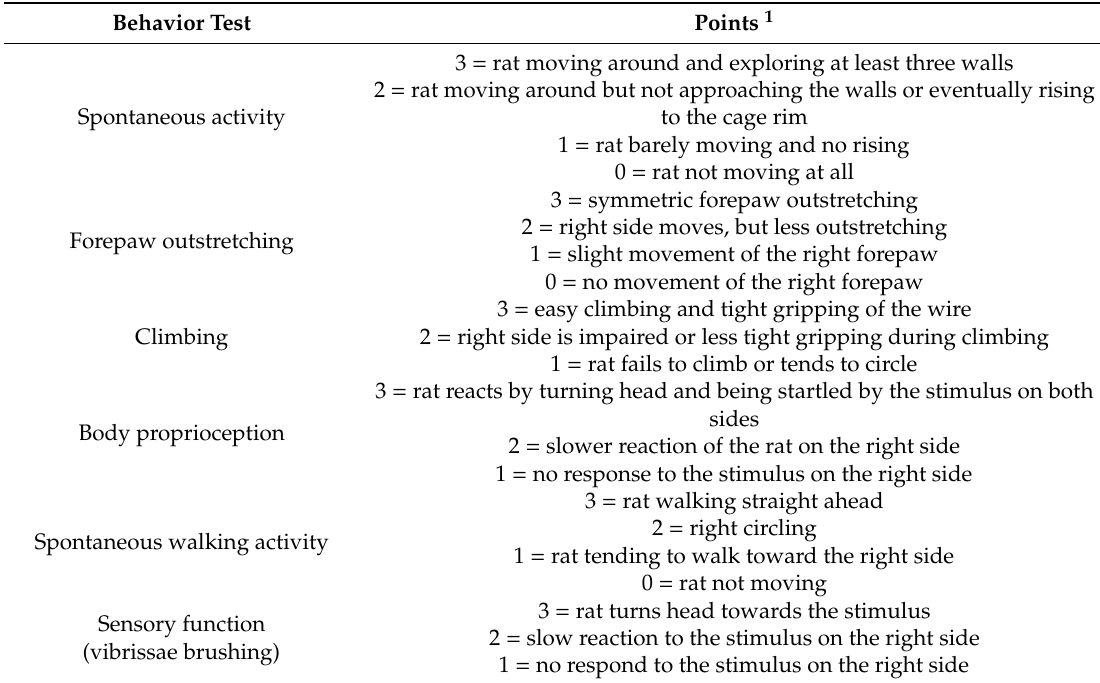
Table 1. Overview of the Garcia behavioral